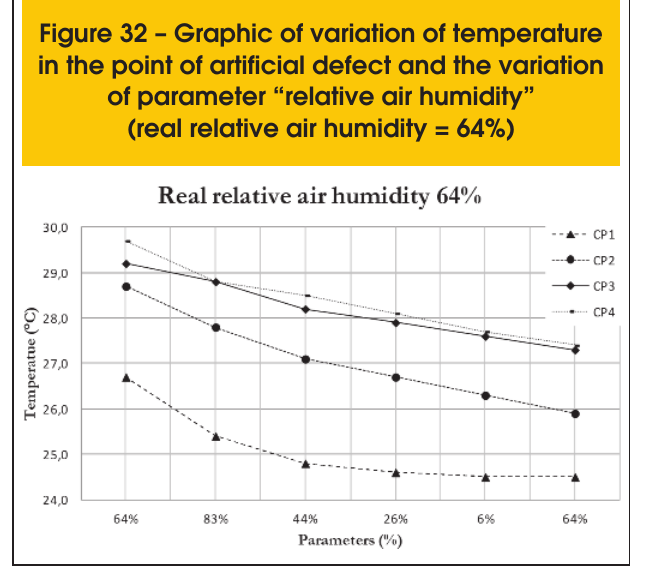
Figure 34 – Graphic of variation of temperature in the point of artificial defect and the variation of parameter of thermal emissivity (real thermal emissivity =